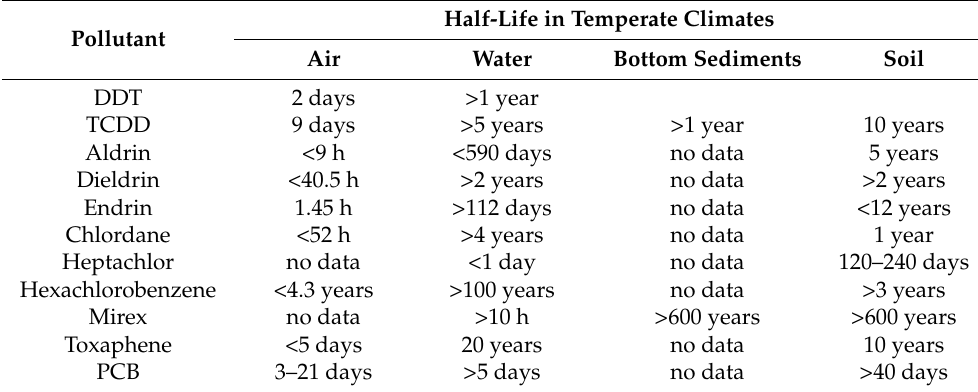
Table 3. Half-life of some xenobiotics in the environment [88]. Half-Life in Temperate Climates Pollutant Air Water Bottom Sediments